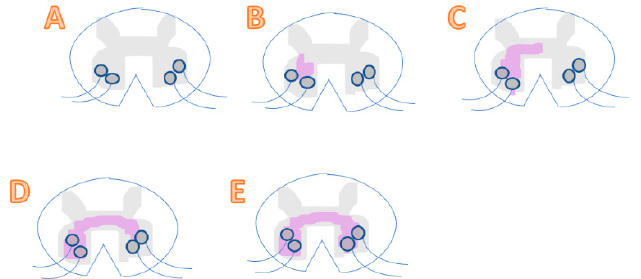
Figure 1. ( A ) A healthy spinal cord with neurons unharmed. ( B ) A pre-symptomatic stage where there is a presence of a local motor neuron dysfunction in the spinal cord, without any clinical symptoms yet. ( C ) Represents a spinal cord during its early symptomatic stage. Spreading of dysfunction in motor neurons occurs and starts showing symptoms. ( D ) A mid-symptomatic stage where dysfunction and degeneration propagate throughout adjacent neurons and regions, thus showing regional dysfunction of neurons. ( E ) The final stage where toxicity transmits to another region and results in a systemic dysfunction of motor neurons. At this late stage, the patient is diagnosed with severe ALS.